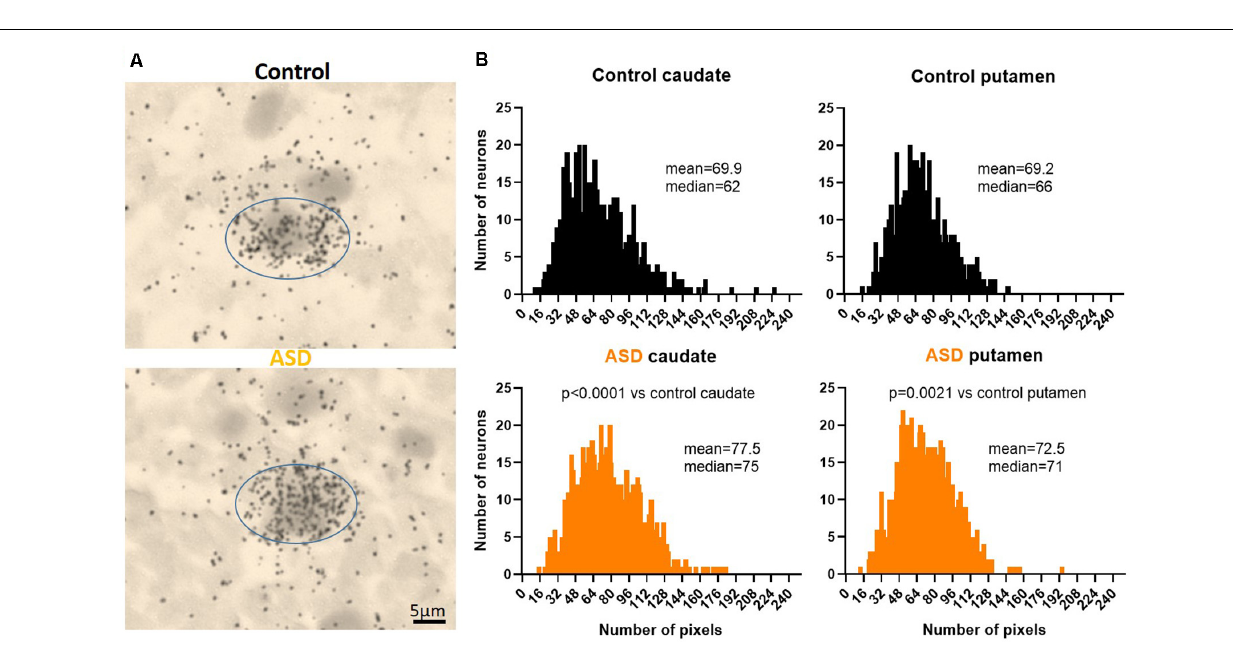
FIGURE 2 | (A) Representative images of control and ASD caudate. Drd2 emulsion autoradiographs. (B) Histograms of Drd2 mRNA labeling within individuals cells quantifies the distribution from emulsion autoradiographs in controls (upper panels) and ASD (lower panels). Differences between control and ASD distributions were analyzed with a Kolmogorov–Smirnov test. n = 10 control, 11 ASD cases; n = 884 control caudate, 1,004 autism caudate, 766 control putamen, 1,000 autism putamen